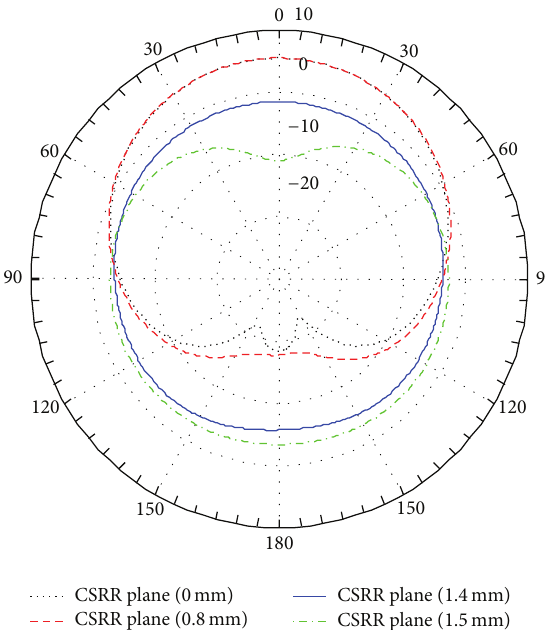
Figure12:Simulationresultsfor 𝐻 -planegainofminiaturizedpatch at different location of CSRR plane moved towards the feed line.